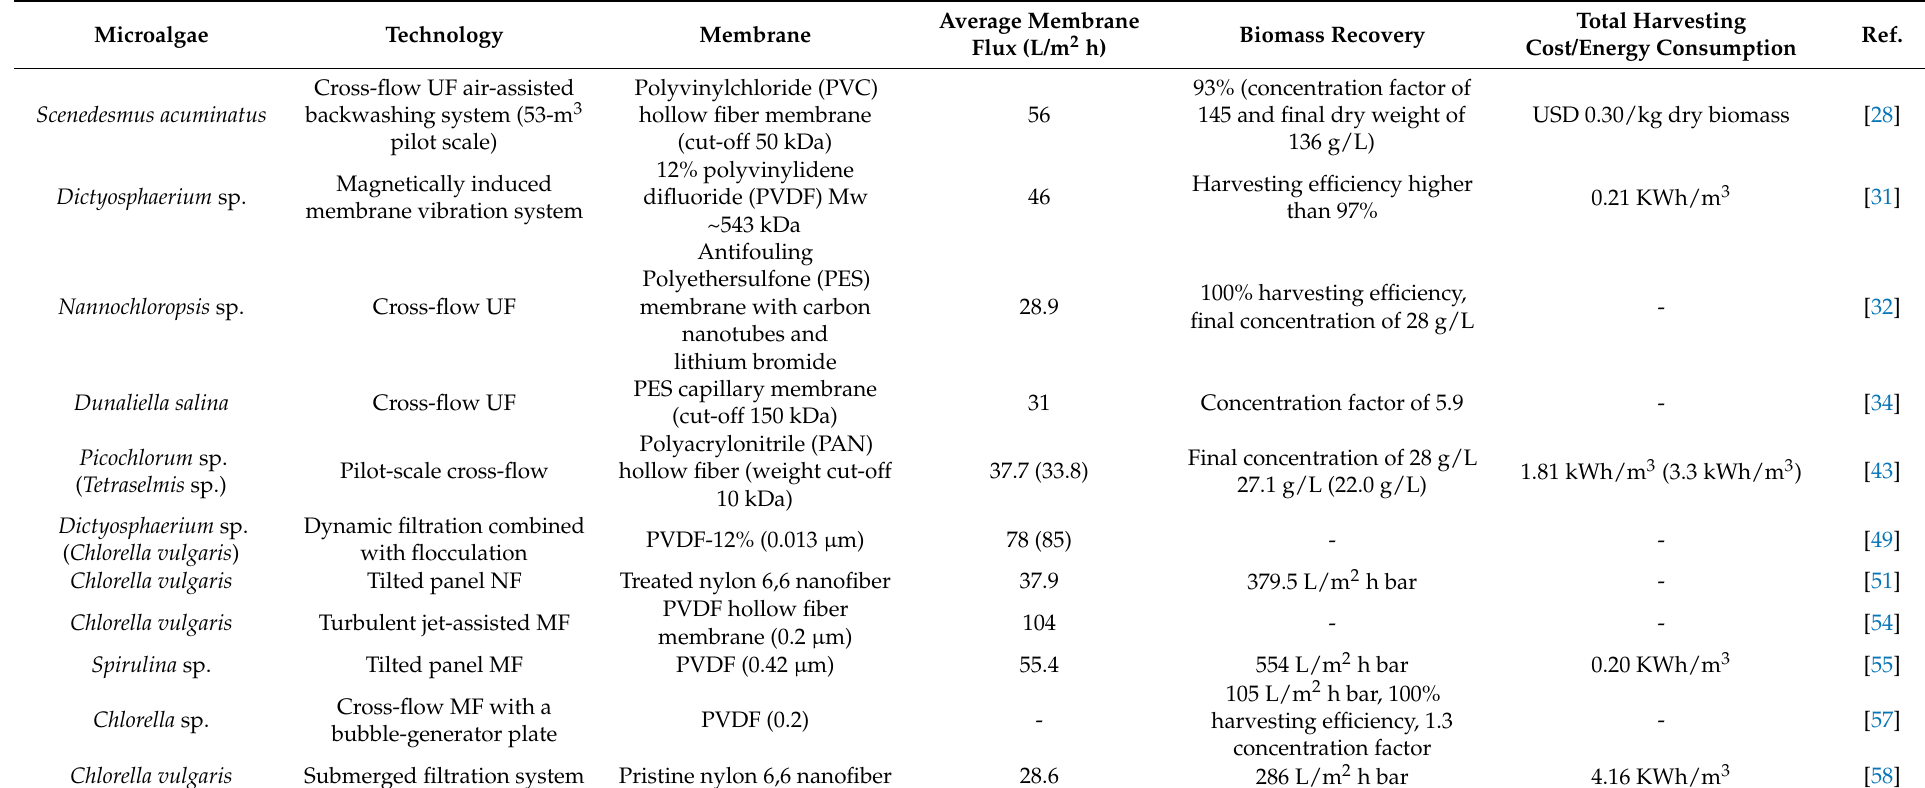
Table 2. Latest works on microalgal membrane